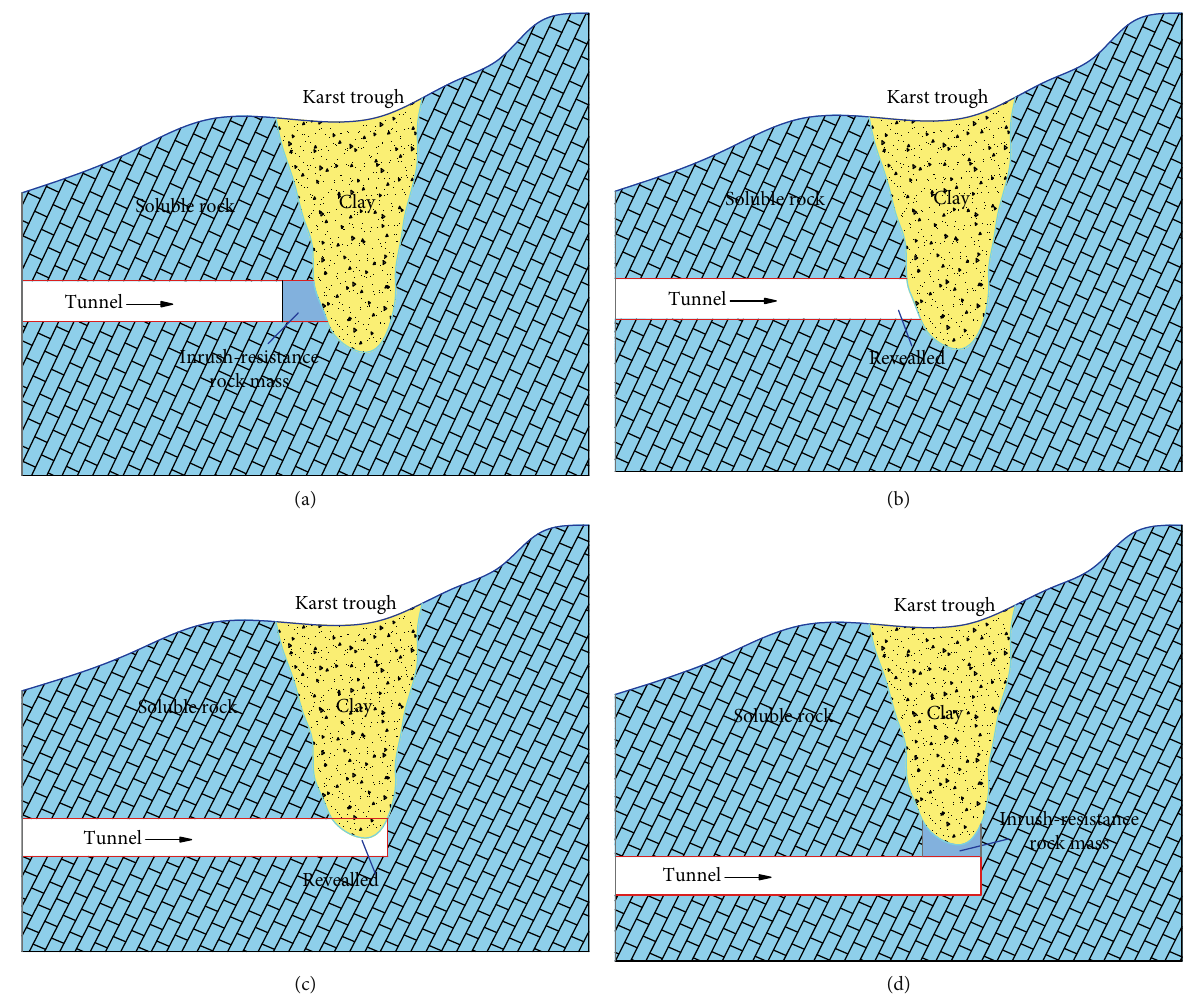
Figure 9: Collapse and mud inrush mode of the fi lled karst trough: (a) rock mass failure of tunnel face; (b) direct exposure of tunnel face; (c) direct exposure of tunnel roof; (d) rock mass failure of tunnel